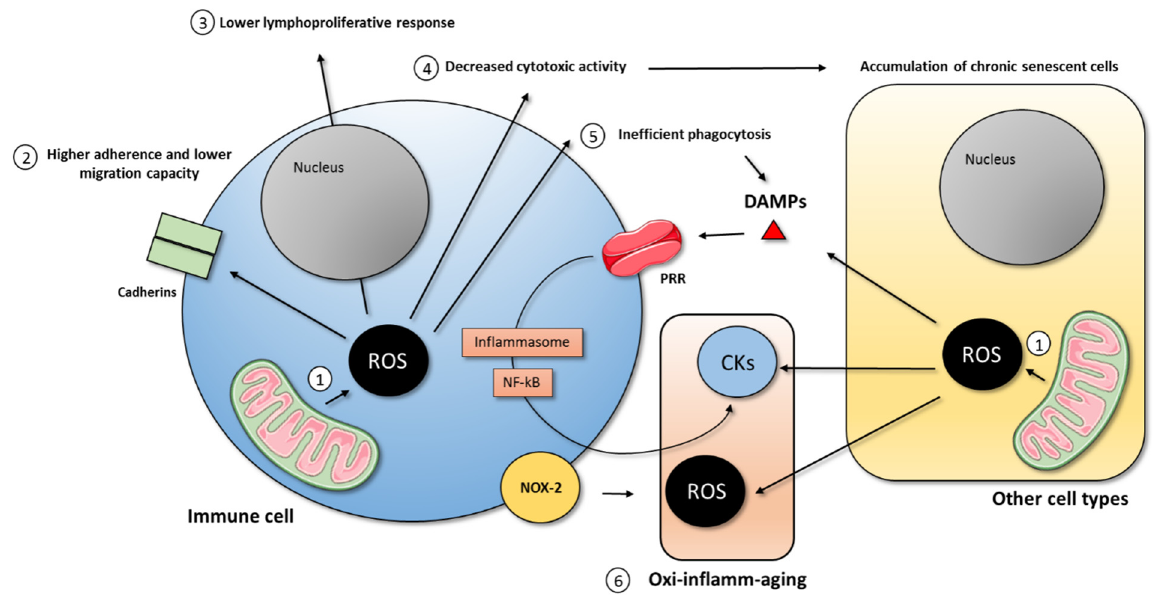
Figure 2. Effects of immunosenescence in oxi-inflamm-aging . 1. Aging starts with the leakage of reactive oxygen species (ROS) that happens in the mitochondria, that react with the mitochondrial DNA (mtDNA) and cause mitochondrial dysfunction, which increases ROS production and generation of mtDNA fragments. These fragments travel to the nucleus and insert into nDNA generating DNA damage and genomic instability. These ROS beyond a threshold cause the cell to enter senescence and develop a senescence-associated secretory phenotype (SASP), which happens in both immune and non-immune cell types. 2. ROS impact the expression of cadherins and integrins, causing a higher adherence and lower migration capacity of immune cells. 3. DNA damage results in a lower lymphoproliferative response. 4. ROS decrease the cytotoxic activity of immune cells that is responsible for the accumulation of chronic senescent cells in other tissues. 5. Uncontrolled ROS balance also leads to inefficient phagocytosis, which results in the increased concentration of several molecules from both immune and non-immune cells that behave as damage-associated molecular patterns (DAMPs) and that can bind to immune cells and throughout inflammasome and nuclear factor kappa B (NF- κ B) activation induce the production of inflammatory mediators (cytokines, CKs) causing inflamm-aging. The accumulation of chronic senescent cells, together with the increased pro-inflammatory mediators at the systemic level, causes excessive production of ROS by immune cells, mainly phagocytes through NADPH-oxidase (NOX-2), to destroy and remove these senescent cells. 6. This situation generates vicious spiral feedback of oxidation and inflammation with aging (oxi-inflamm-aging), in which immune cells play a central